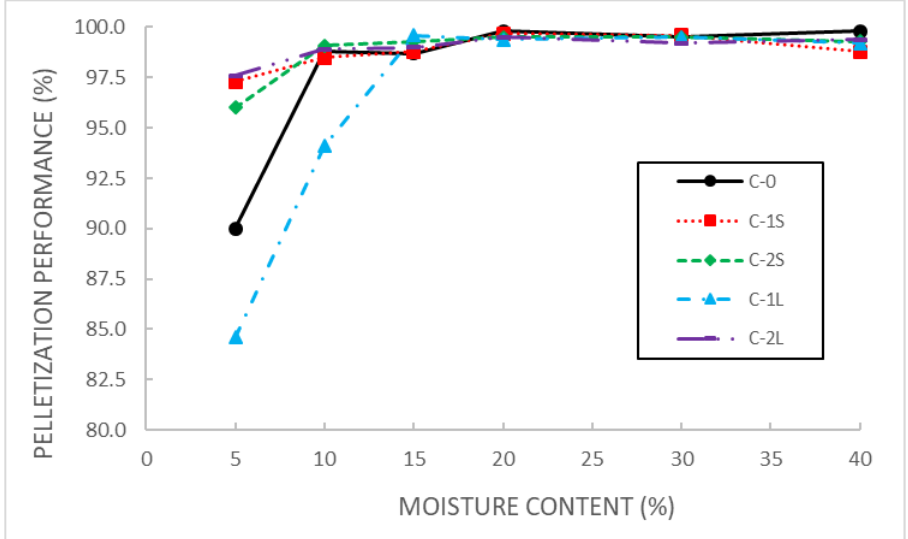
Figure 2. Pelletization performance.